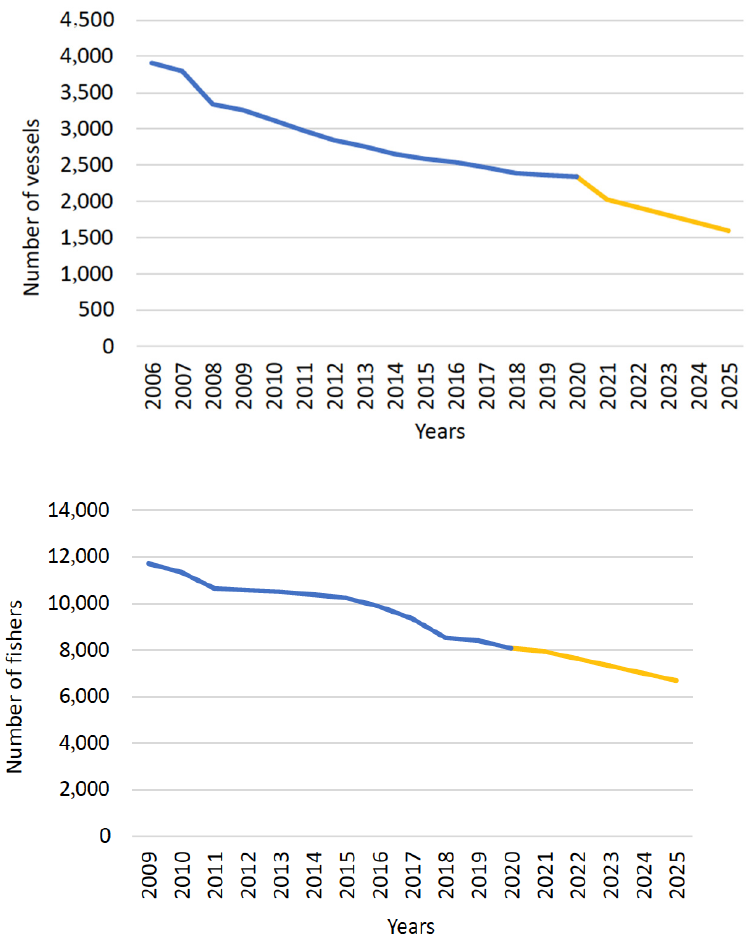
Figure 8. Evolution of the number of vessels and fishers 12 .